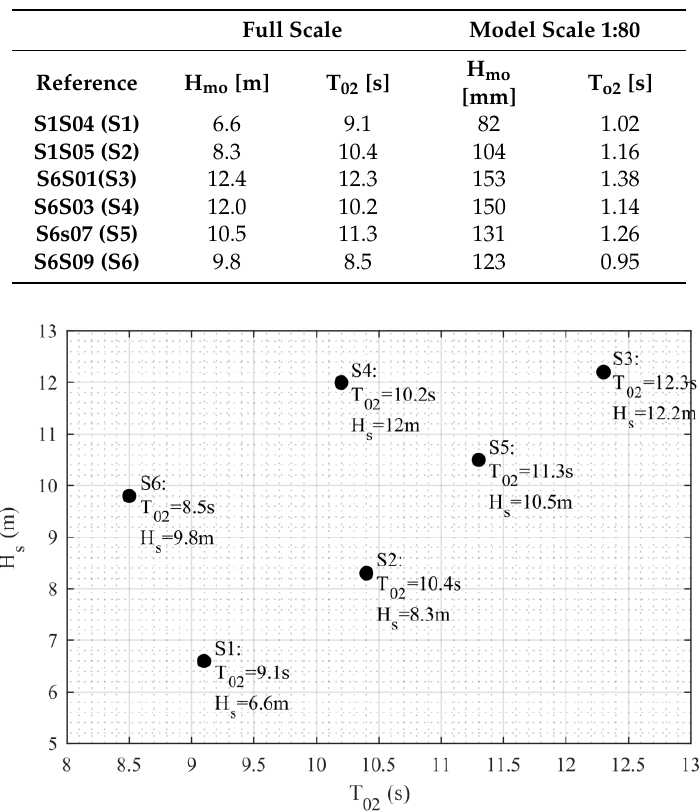
Table 5. Full-scale and model-scale values for selected sea states.